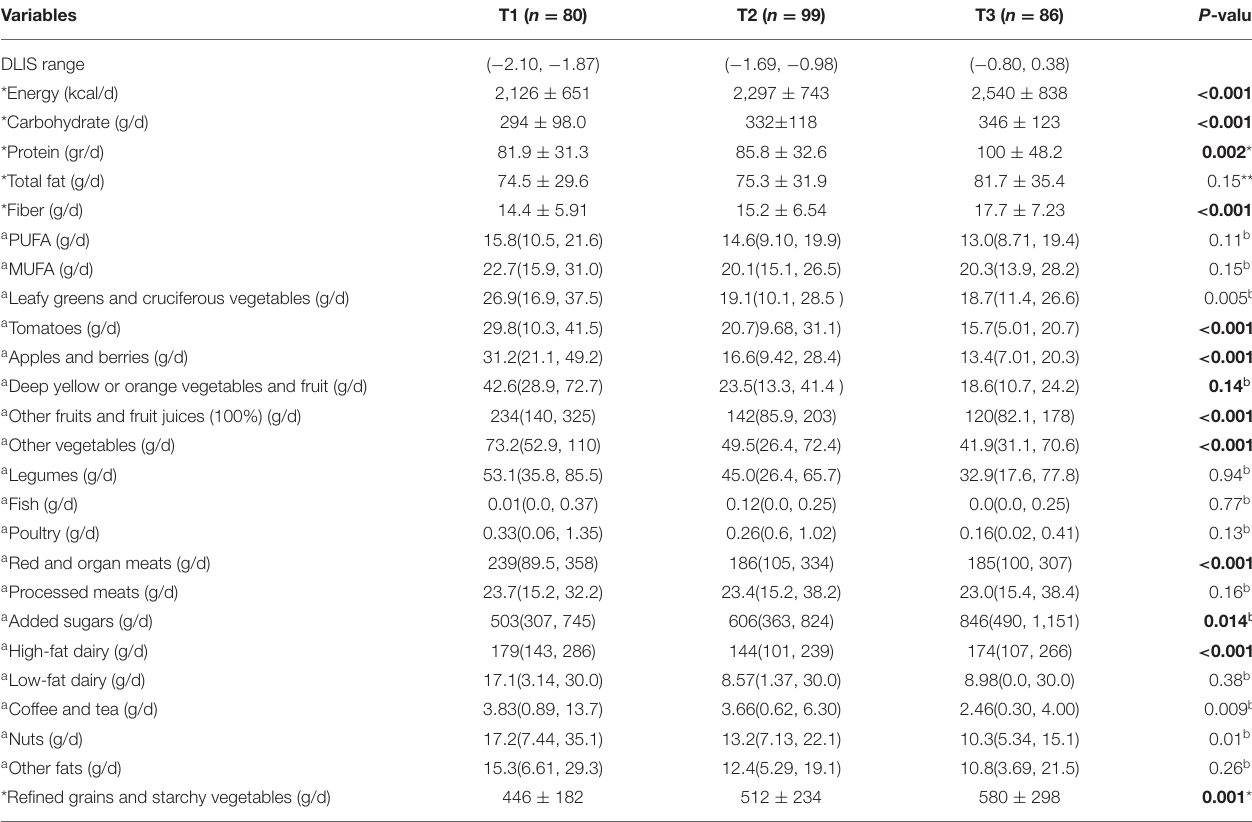
TABLE 2 | Dietary intakes of study participants across tertile of the DLIS.